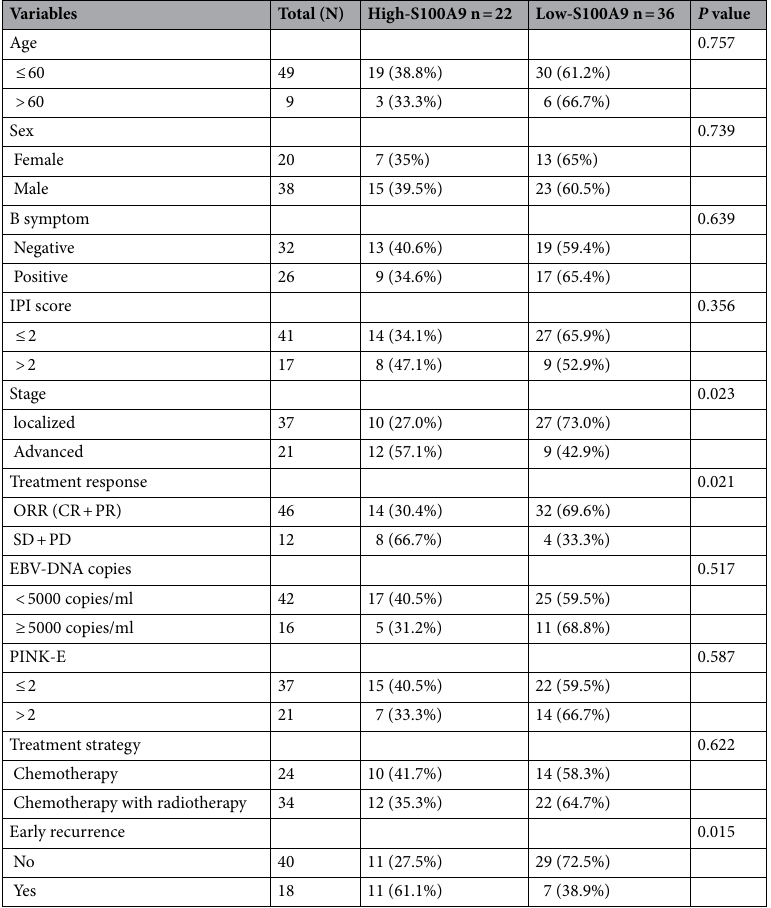
Table 1. Clinical relevance of serum S100A9 with pathological characteristics, response rate and early recurrence in NKTCL patients. IPI international prognostic index, ORR overall response rate, CR complete